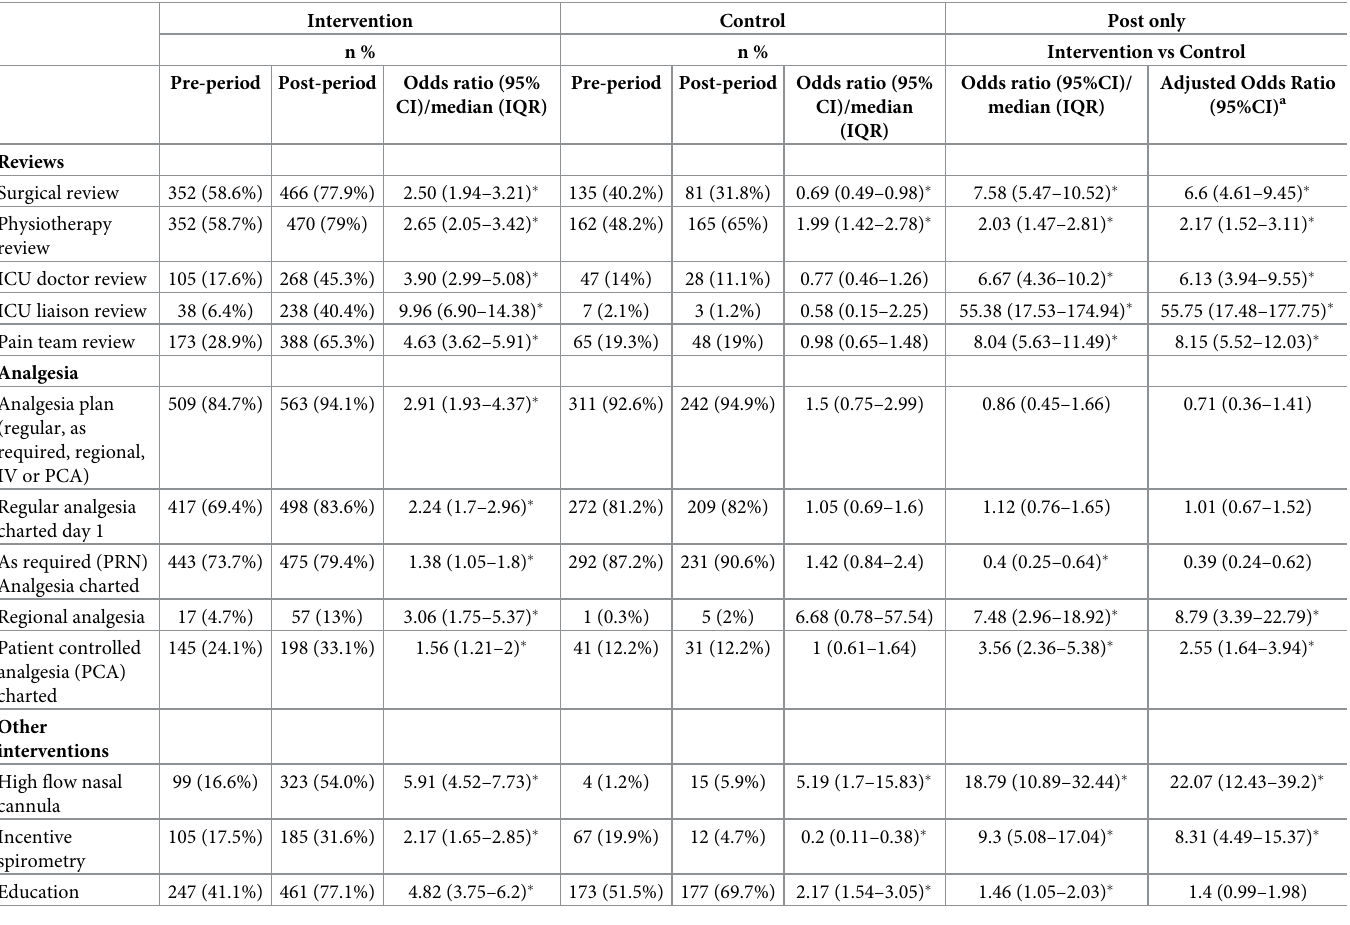
Table 3. Intervention delivery comparison between intervention and control. Intervention Control Post only n % n % Intervention vs